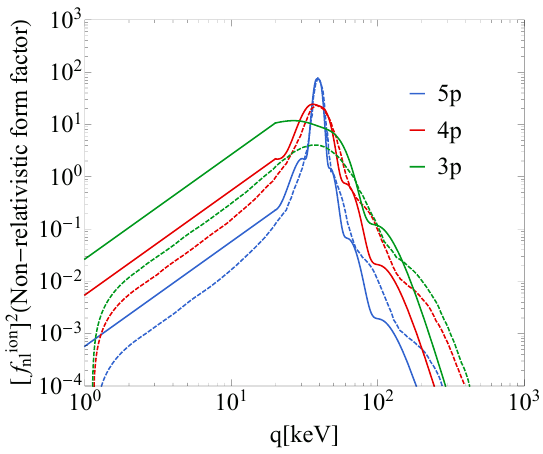
Figure 1 . Ionization form factor as a function of momentum transfer q in keV for 5 p, 4 p, 3 p shells in blue, red and green lines. Our results are shown in solid lines, in comparison to those in dashed lines in ref. [8]. We set E R = 1 . 5 keV for